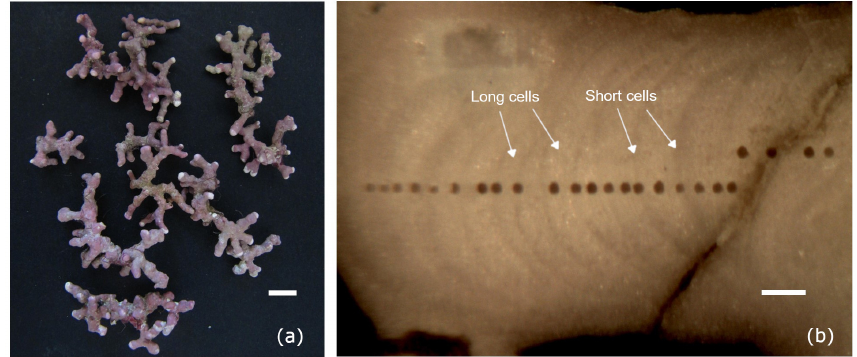
Figure 2. (a) Thalli of Lithothamnion corallioides collected in Morlaix (scale bar: 5mm). (b) Longitudinal section through the L. corallioides branch sampled in Morlaix showing the LA-ICP-MS transects targeting each growth band (scale bar: